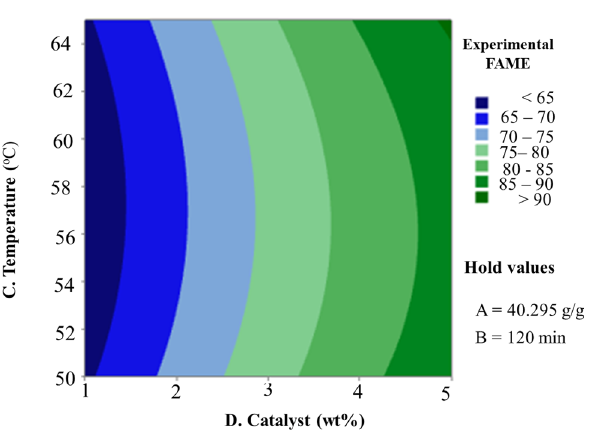
Figure 10. Contour plot of experimental FAME vs. (C) Temperature (D)